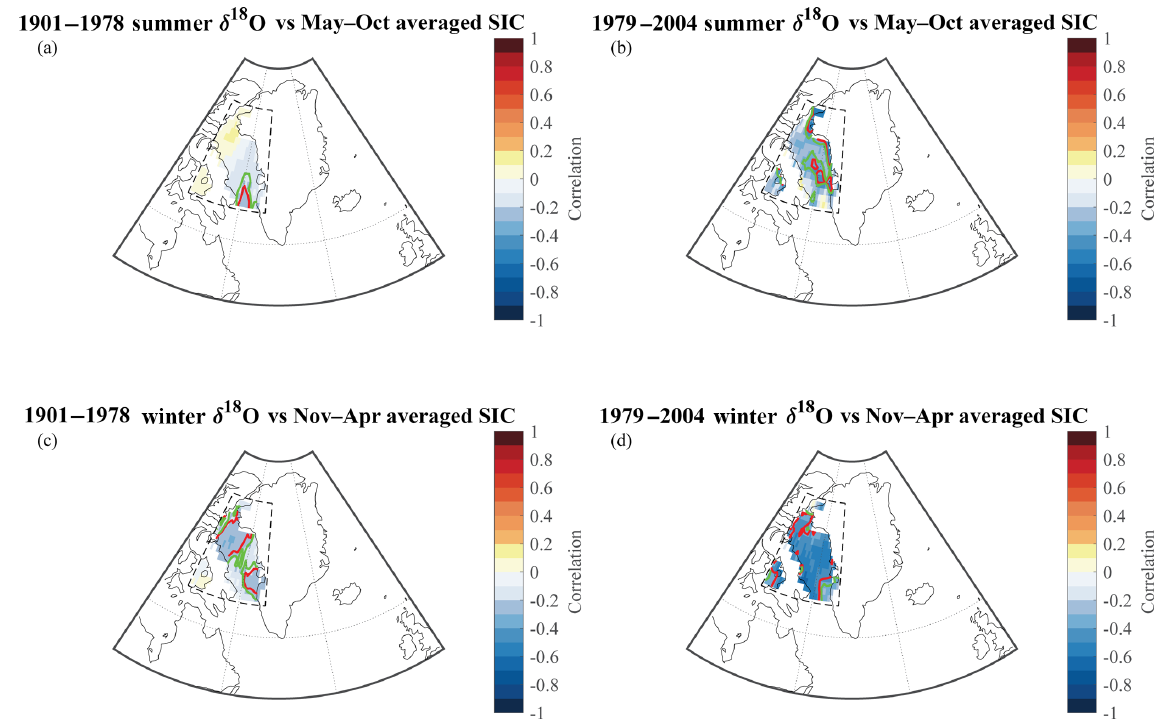
Figure 6. The spatial correlation map between NEEM seasonal δ 18 O and SIC over Baffin Bay for the period prior to satellite observations (a, c) and the satellite observation period (b, d) . The winter data are averaged for November–April, and the summer data are averaged for the May–October. The red solid lines indicate significant correlation at the 95% confidence level, and the green solid lines indicate this at the 90% confidence level ( t